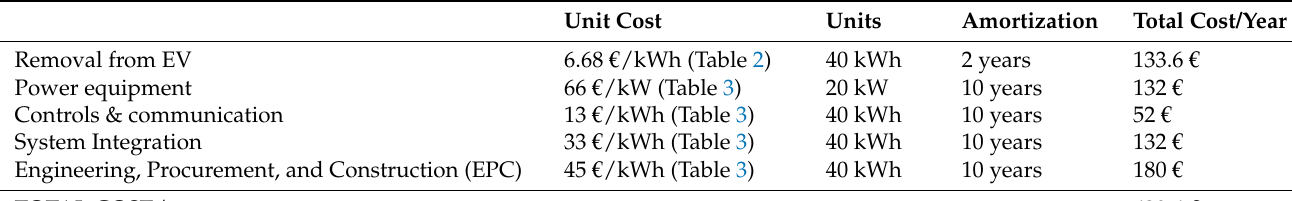
Table 8. Example cost assessment of the battery’s transition to second life.